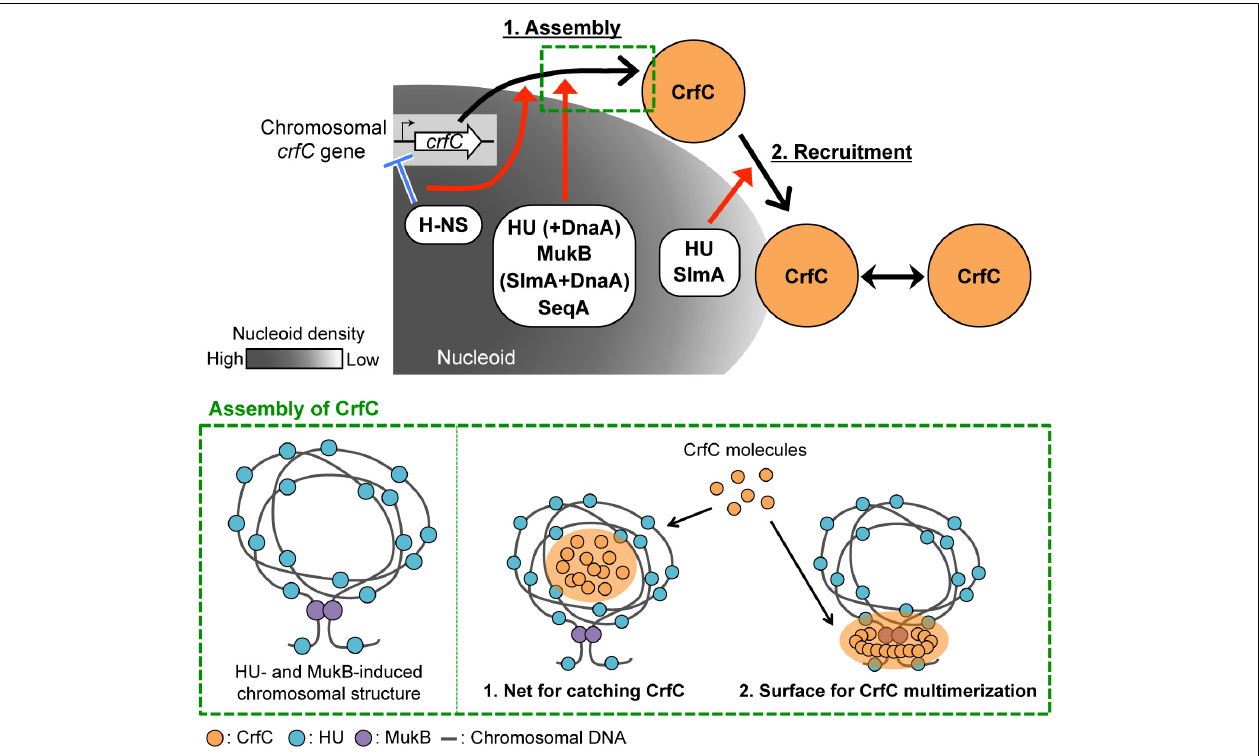
FIGURE 9 | Model of subcellular localization of CrfC. Model of CrfC localization to positions adjacent to the nucleoid pole. We hypothesize that CrfC localization is controlled in a two-step process: (1) assembly and (2) recruitment. H-NS promotes efficient assembly of CrfC by spatiotemporally controlling the CrfC expression and organizing the nucleoid structure. HU and MukB provides the specific nucleoid structure that influences assembly of CrfC by concentrating CrfC molecules or stimulating CrfC multimerization. The lower panel shows possible mechanisms for stimulation of CrfC multimerization. A specific DNA folding is constructed depending on HU and MukB ( left ) (Lioy et al., 2018). CrfC molecules might be concentrated in the DNA folding or might be stimulated in multimerization by interaction with the surface of the DNA folding ( right ) (see the text). DnaA stimulates CrfC assembly either directly or indirectly in the absence of HU or SlmA. Also, SeqA stimulates CrfC assembly. DnaA and SeqA might stimulate functional substructures of the nucleoid. DnaA can interact with HU (Chodavarapu et al., 2008a). CrfC assembly then interacts with the nucleoid pole-specific structure, which is organized by HU and SlmA, directing CrfC localization at the nucleoid poles. There, CrfC foci might have vibrating motion, causing temporal dissociation from the nucleoid pole. These specific nucleoid organization factors cooperatively promote the proper subcellular dynamics of CrfC. Low nucleoid density in the nucleoid-polar region also could be